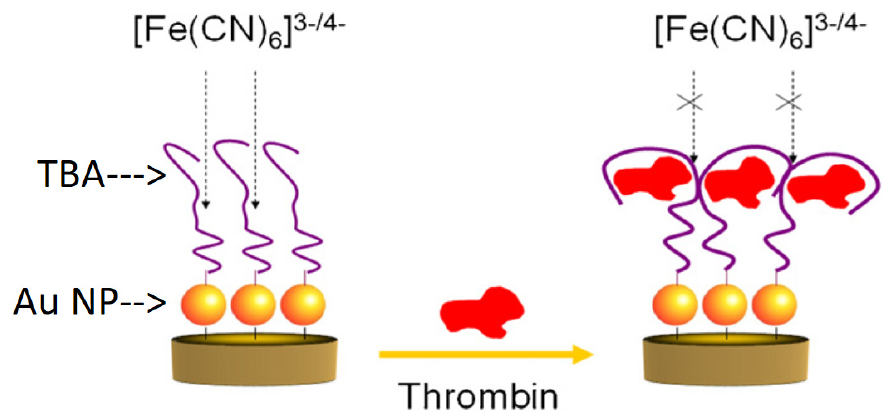
Figure 5. Au NP enabled thrombin biosensors. Conformational changes of TBA (immobilized on Au NPs) upon binding to thrombin vary the charge transfer resistances in the presence of [Fe(CN) 6 ] 3 − /4 − redox couple. Adapted from [76].